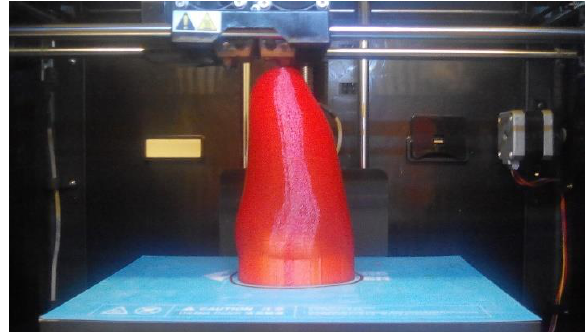
Figure 6. Manufacturing of elastic stump shell for the strength test.